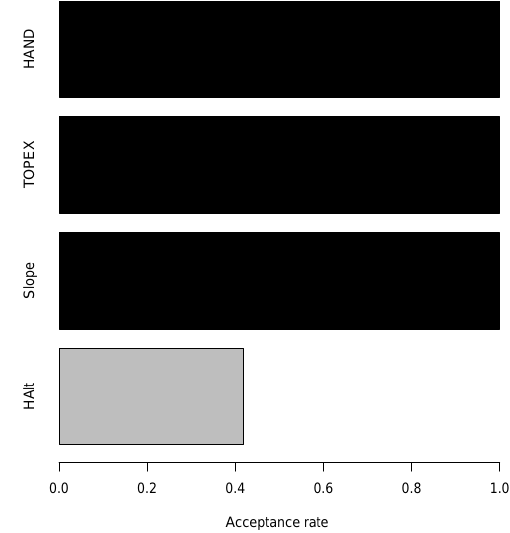
Figure 4. Results of the Kuo–Mallick algorithm for variable selec- tion. Variables were included in the final model when their value was close to 100%: slope, TOPEX and